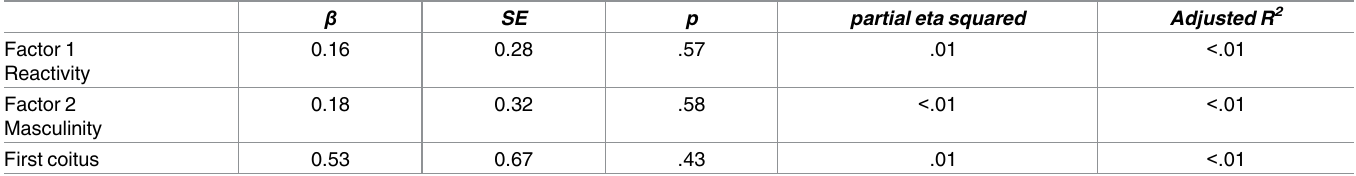
Table 4. Regression analysesshowing associations between father absence and outcome measuresfor (Australian) male participants.